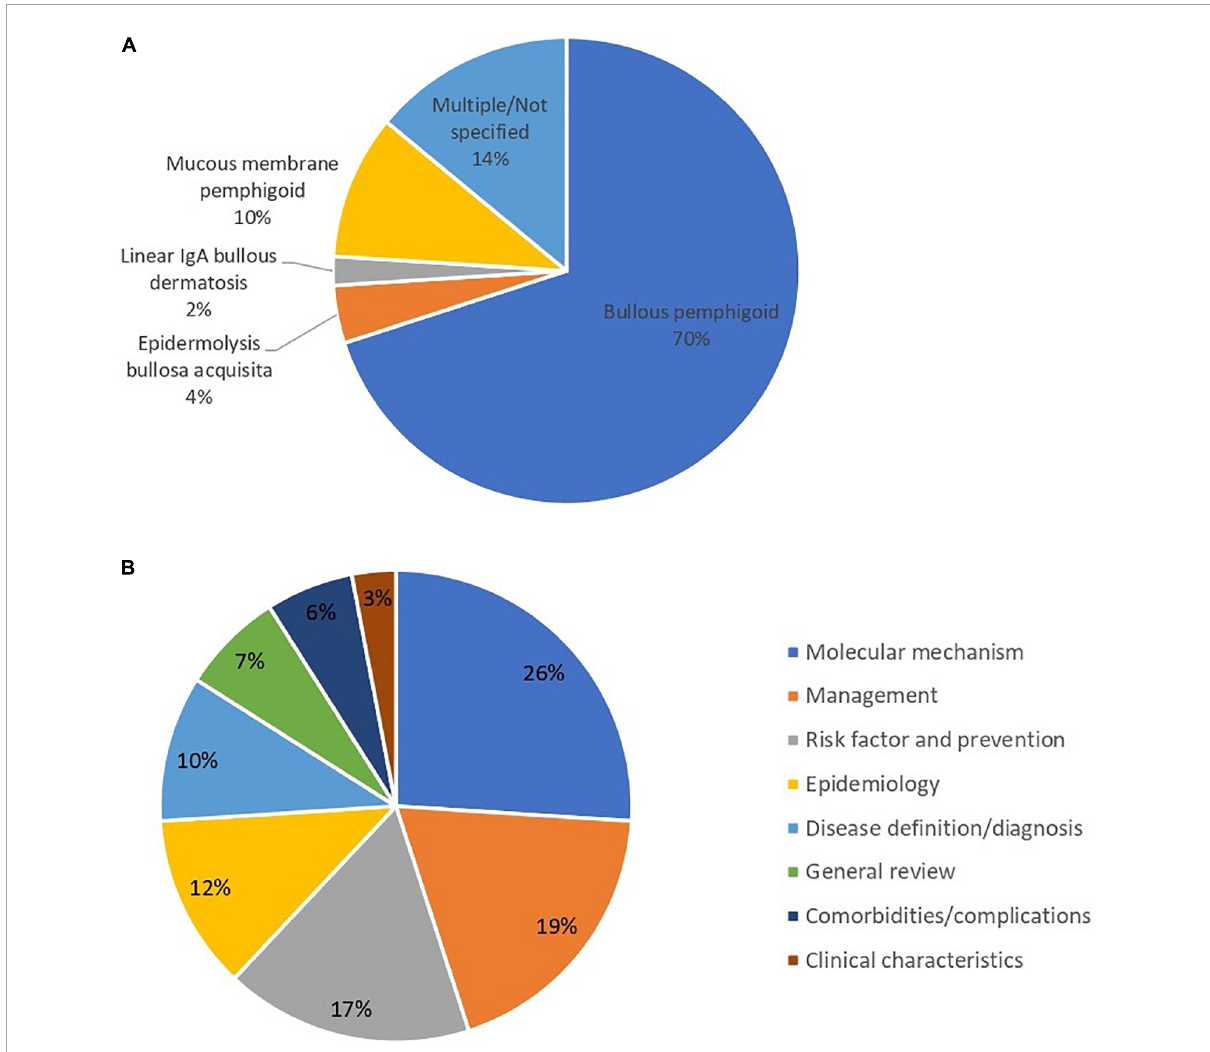
FIGURE5 (A) Distribution of subcategories of pemphigoid diseases in the main focus of top 100 publications. (B) Main focus of the top 100 cited studies of pemphigoid